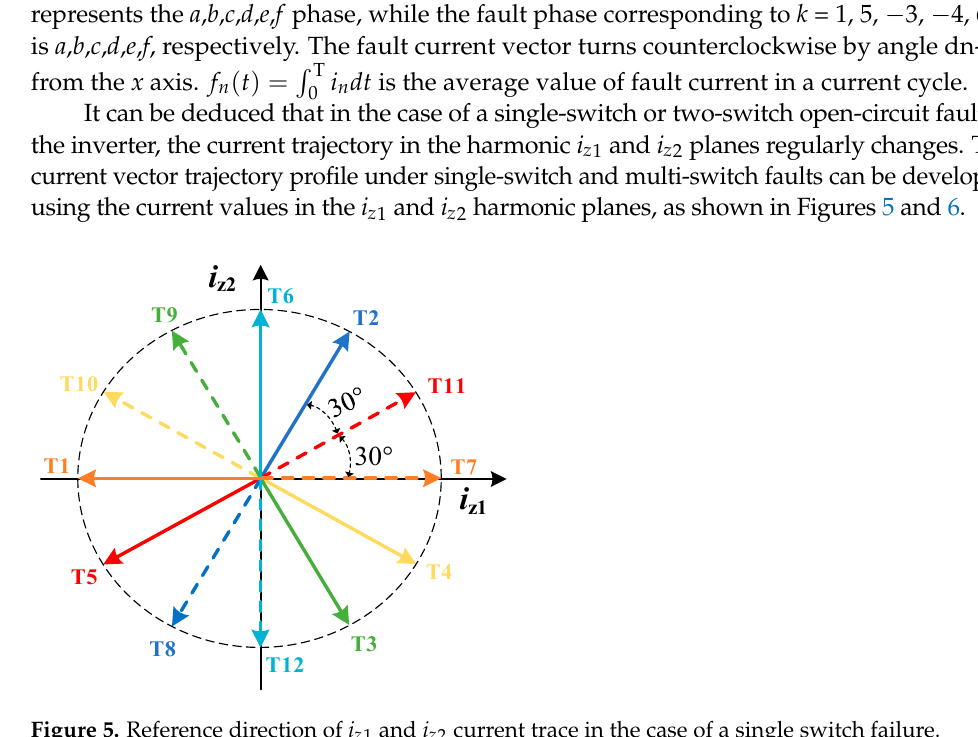
Figure 5. Reference direction of i z1 and i z2 current trace in the case of a single switch failure.